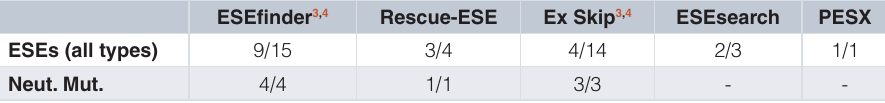
Table 2b. Concordance of splice-prediction programs to information theory-based tools for splicing regulatory